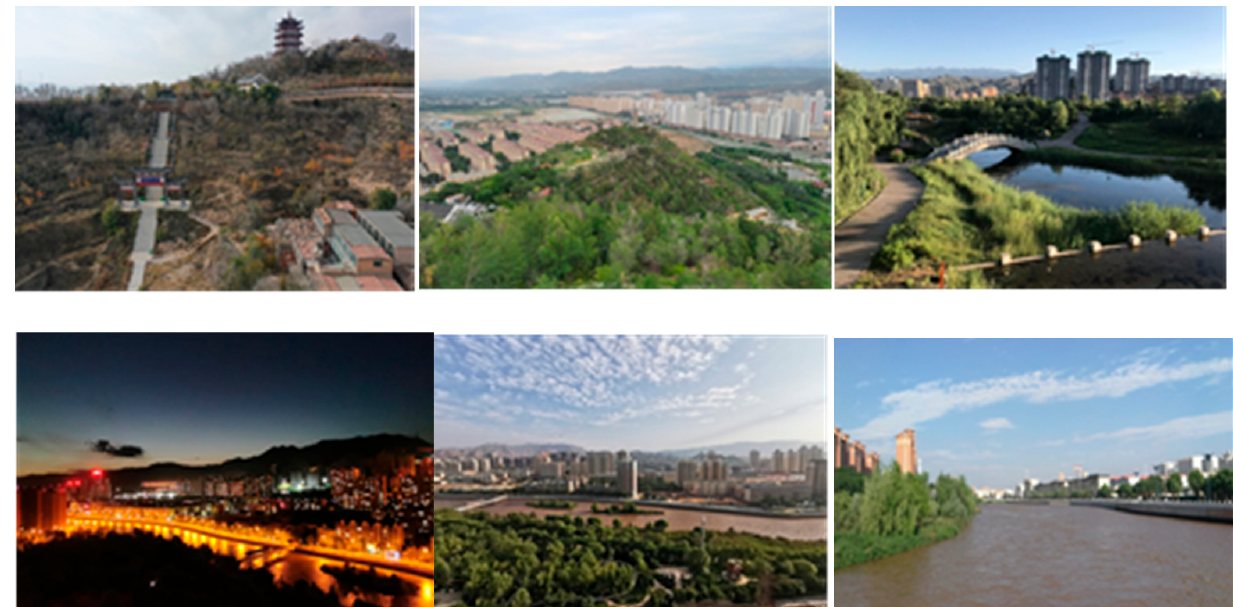
Figure 5. Current Riverside Street View of Xining.